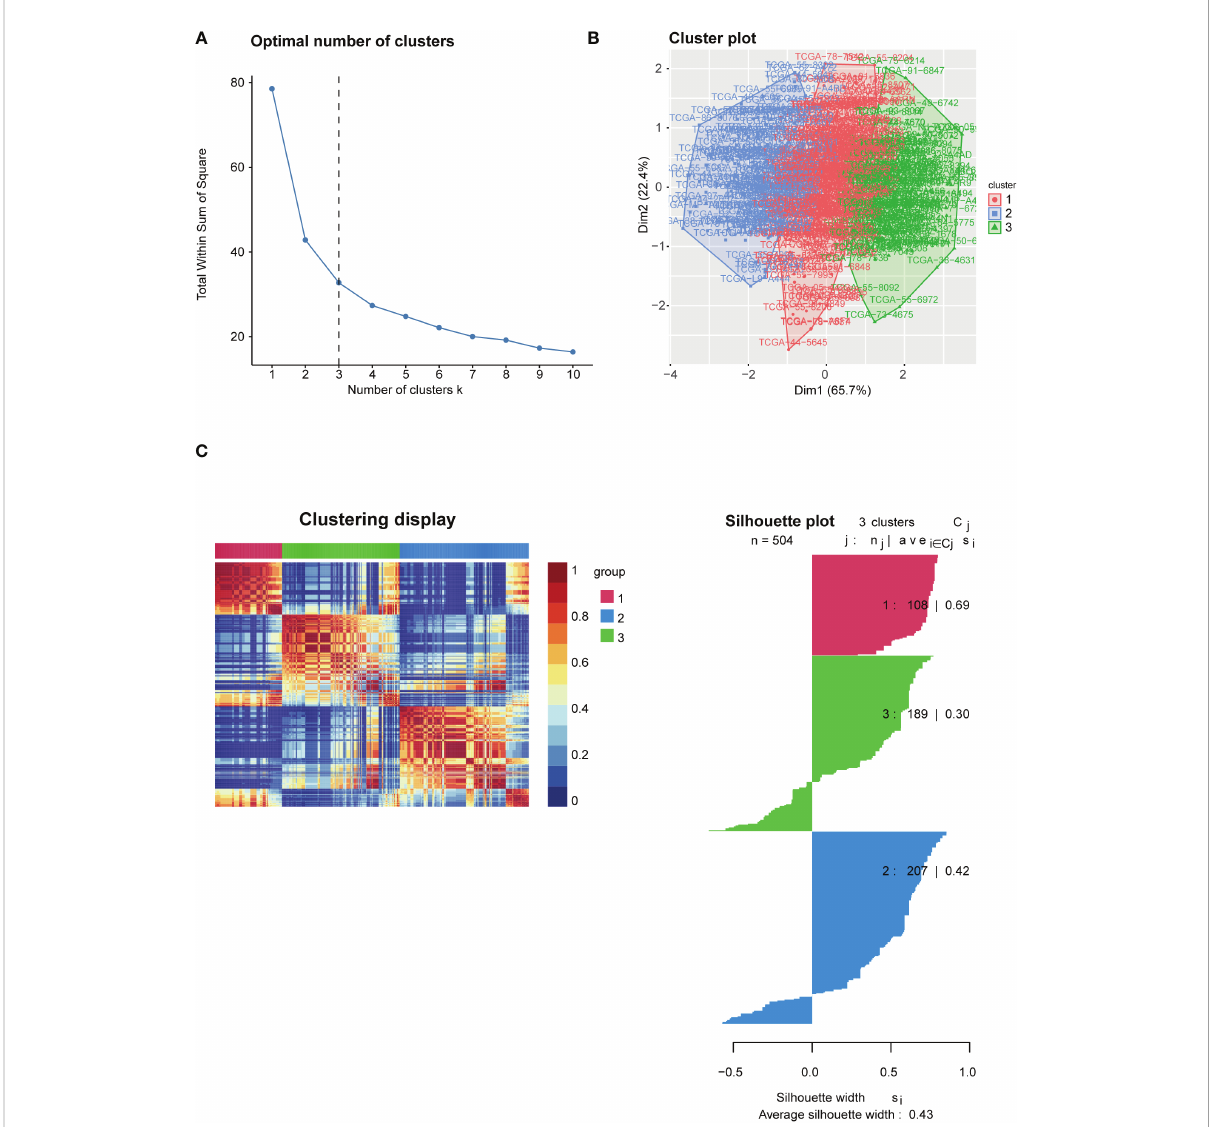
FIGURE 1 Identi fi cation of immune-based subtypes of LUAD. (A) Identi fi cation of best cutoff of the cluster; (B) Distribution of each cluster by the PCA method in the factoextra package; (C) Visualization of each cluster using the NMF method. Identi fi cation of the value of grouping by silhouette width